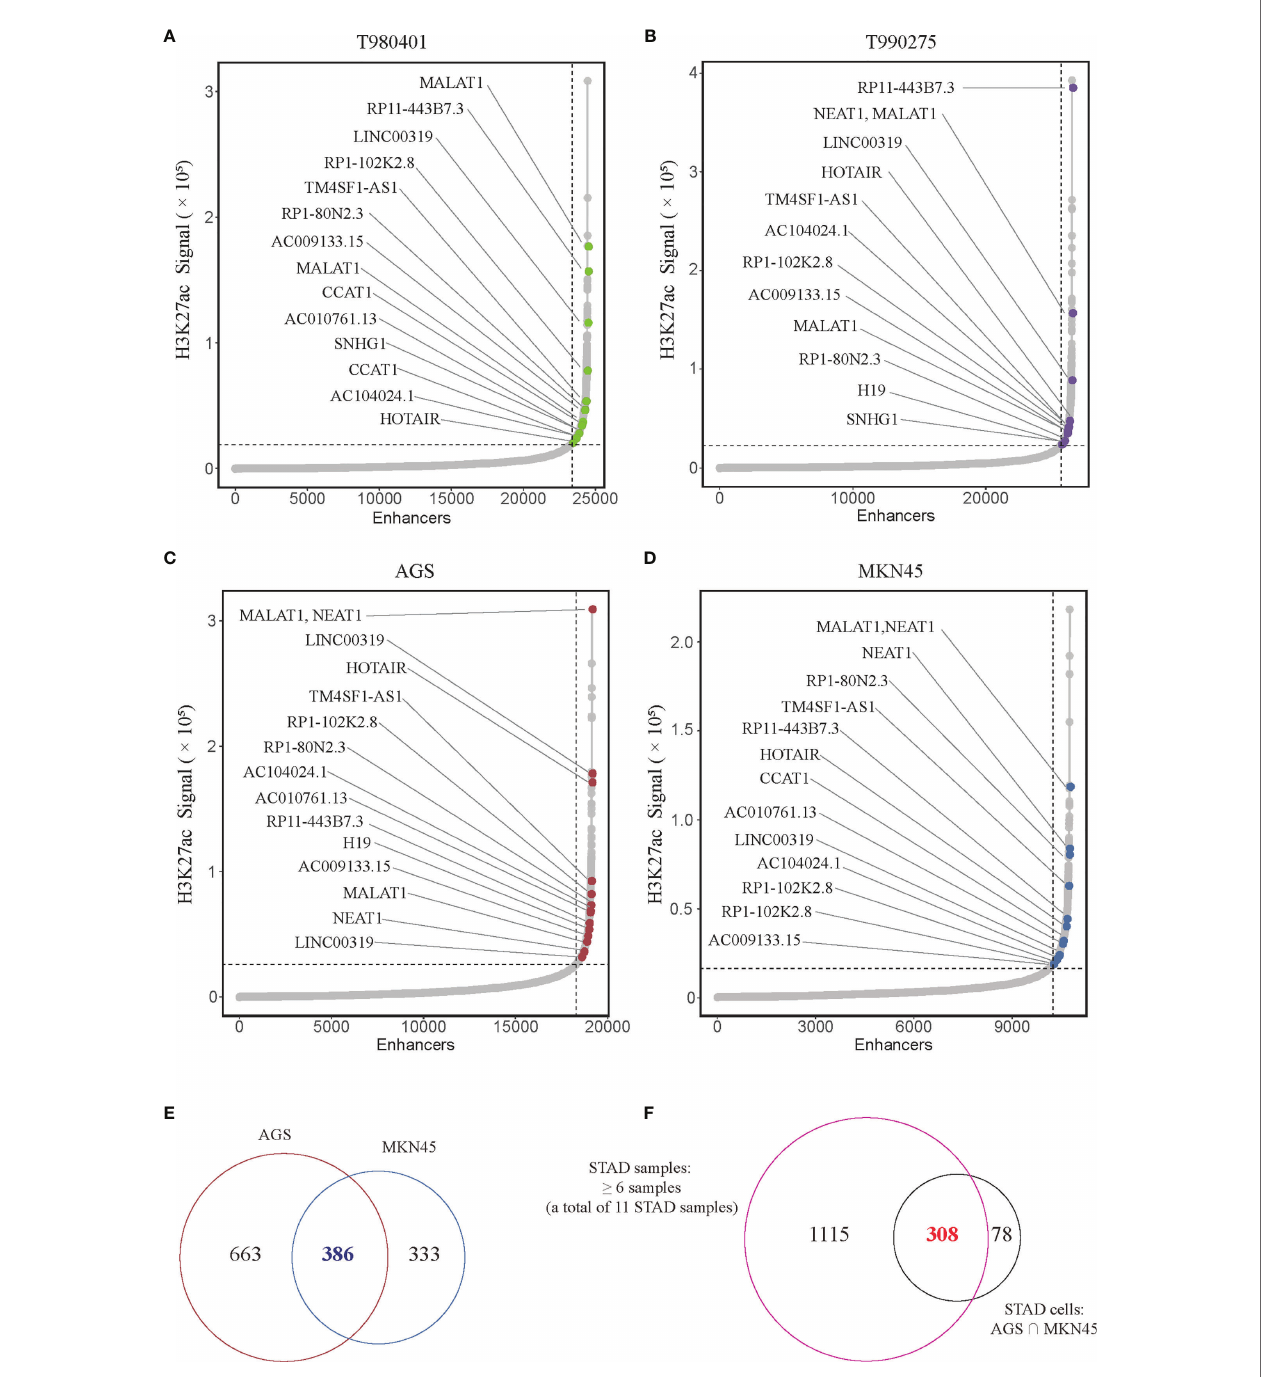
FIGURE 1 | Super-enhancer-associated lncRNAs present in STAD samples and cells. (A – D) Hockey stick plot of SE-associated lncRNAs in two tumor samples (T980401 and T990275) and two STAD cells (AGS and MKN45). Some representations of novel and known SE-associated lncRNAs are shown in color on the curve. (E) Venn diagram showing the intersection of SE-associated lncRNAs in two STAD cells (AGS and MKN45). (F) Venn diagram displaying the intersection of the SE-associated lncRNAs shared in two STAD cells and the SE-associated lncRNAs in at least 6 of 11 STAD samples. ChIP-seq with the H3K27ac antibody in AGS cell lines was from this study, and other H3K27ac ChIP-seq in 11 STAD tissue samples and MKN45 cell lines were downloaded from GEO database (GSE117953;